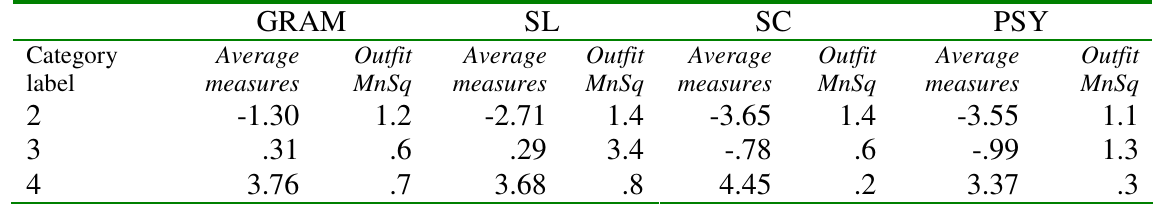
Average Test-taker Ability Measure and Outfit Mean-square Indices (N =